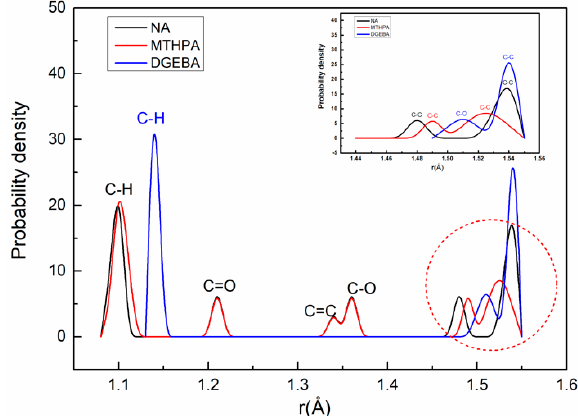
Figure 3. The bond-length distribution of DGEBA, MTHPA and NA monomers.